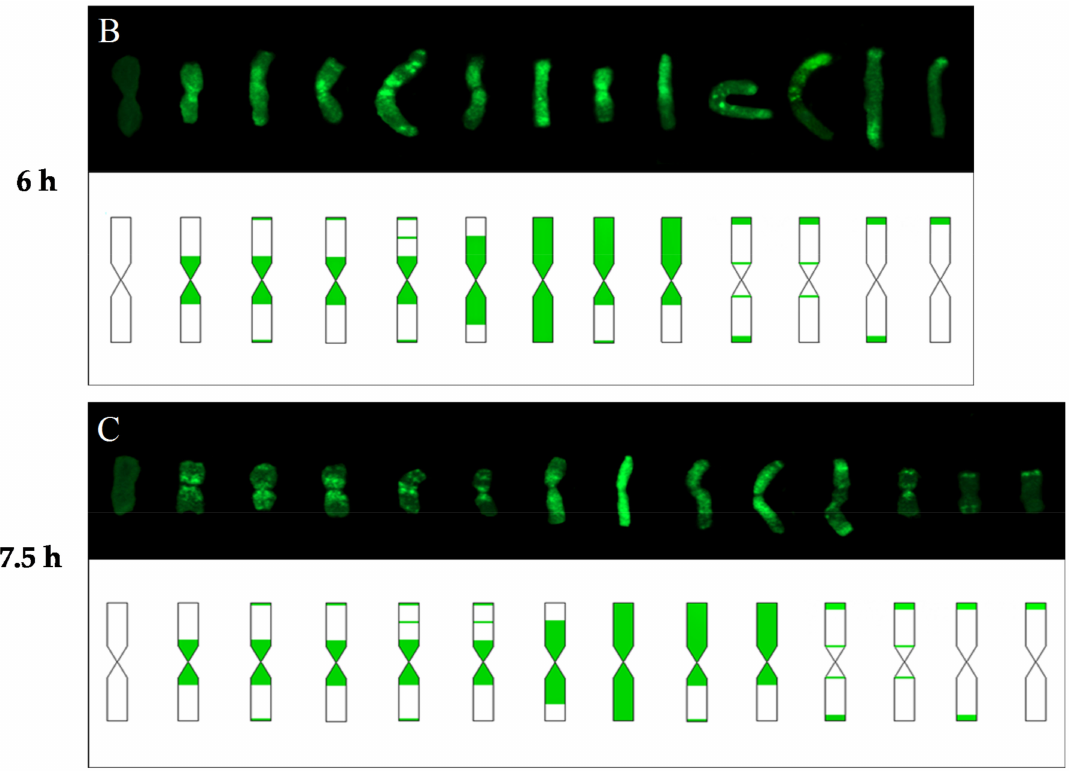
Figure 6. Types of replication patterns in the barley chromosomes in the γ ray-treated roots at 4 h ( A ), 6 h ( B ), and 7.5 h ( C ) after EdU incorporation. Chromosomes with different replication patterns and their corresponding schematic presentation are shown. Only one morphological type of chromosome is presented in order to simplify the